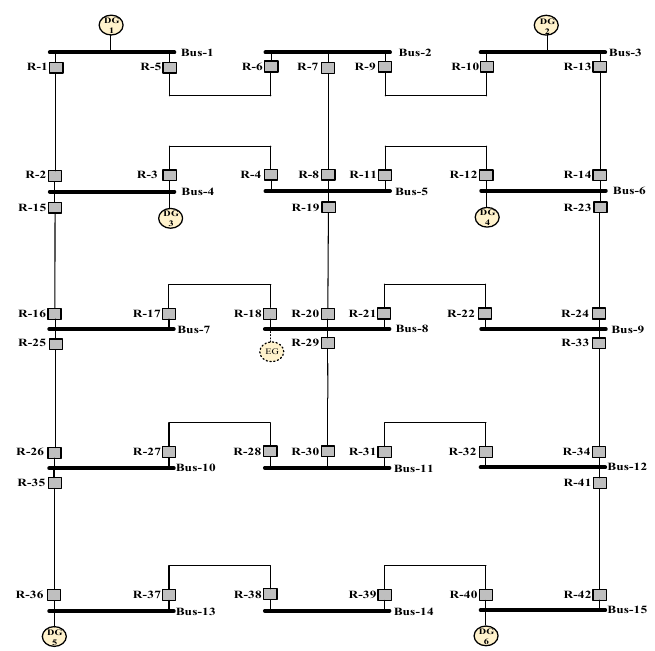
Figure 6. IEEE 15-Bus network.